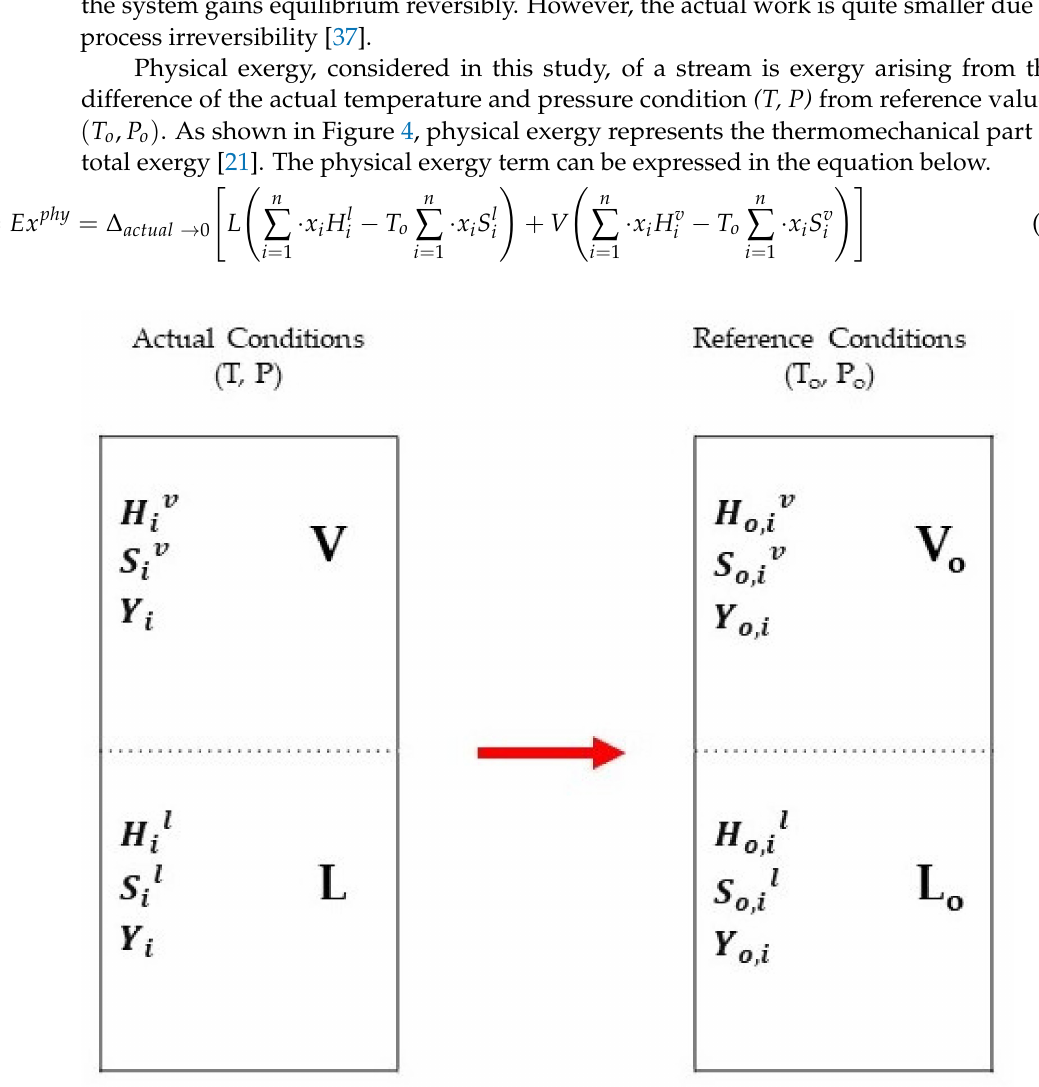
Figure 4. Exergy change from actual to reference